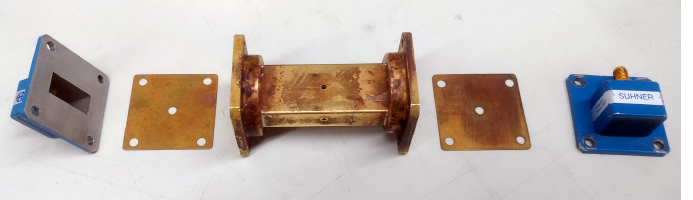
Figure 4. WR90 waveguide with coupling irises and coaxial to waveguide adaptors. The small holes in the waveguide’s broad and narrow walls are used for sample